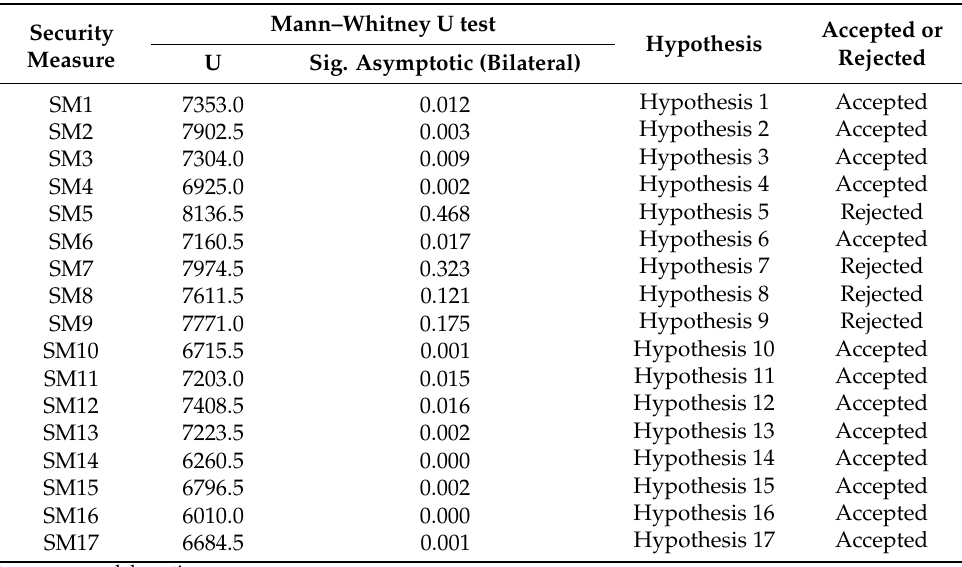
Table 7. Mann–Whitney U test; and Hypothesis accepted and rejected.